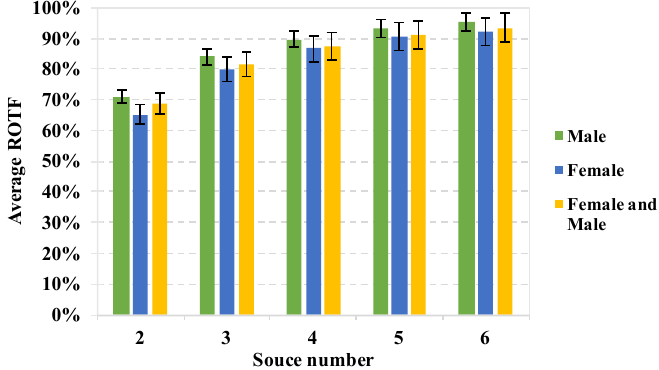
Figure 2. Average ratio of overlapped time-frequency (ROTF) for 2–6